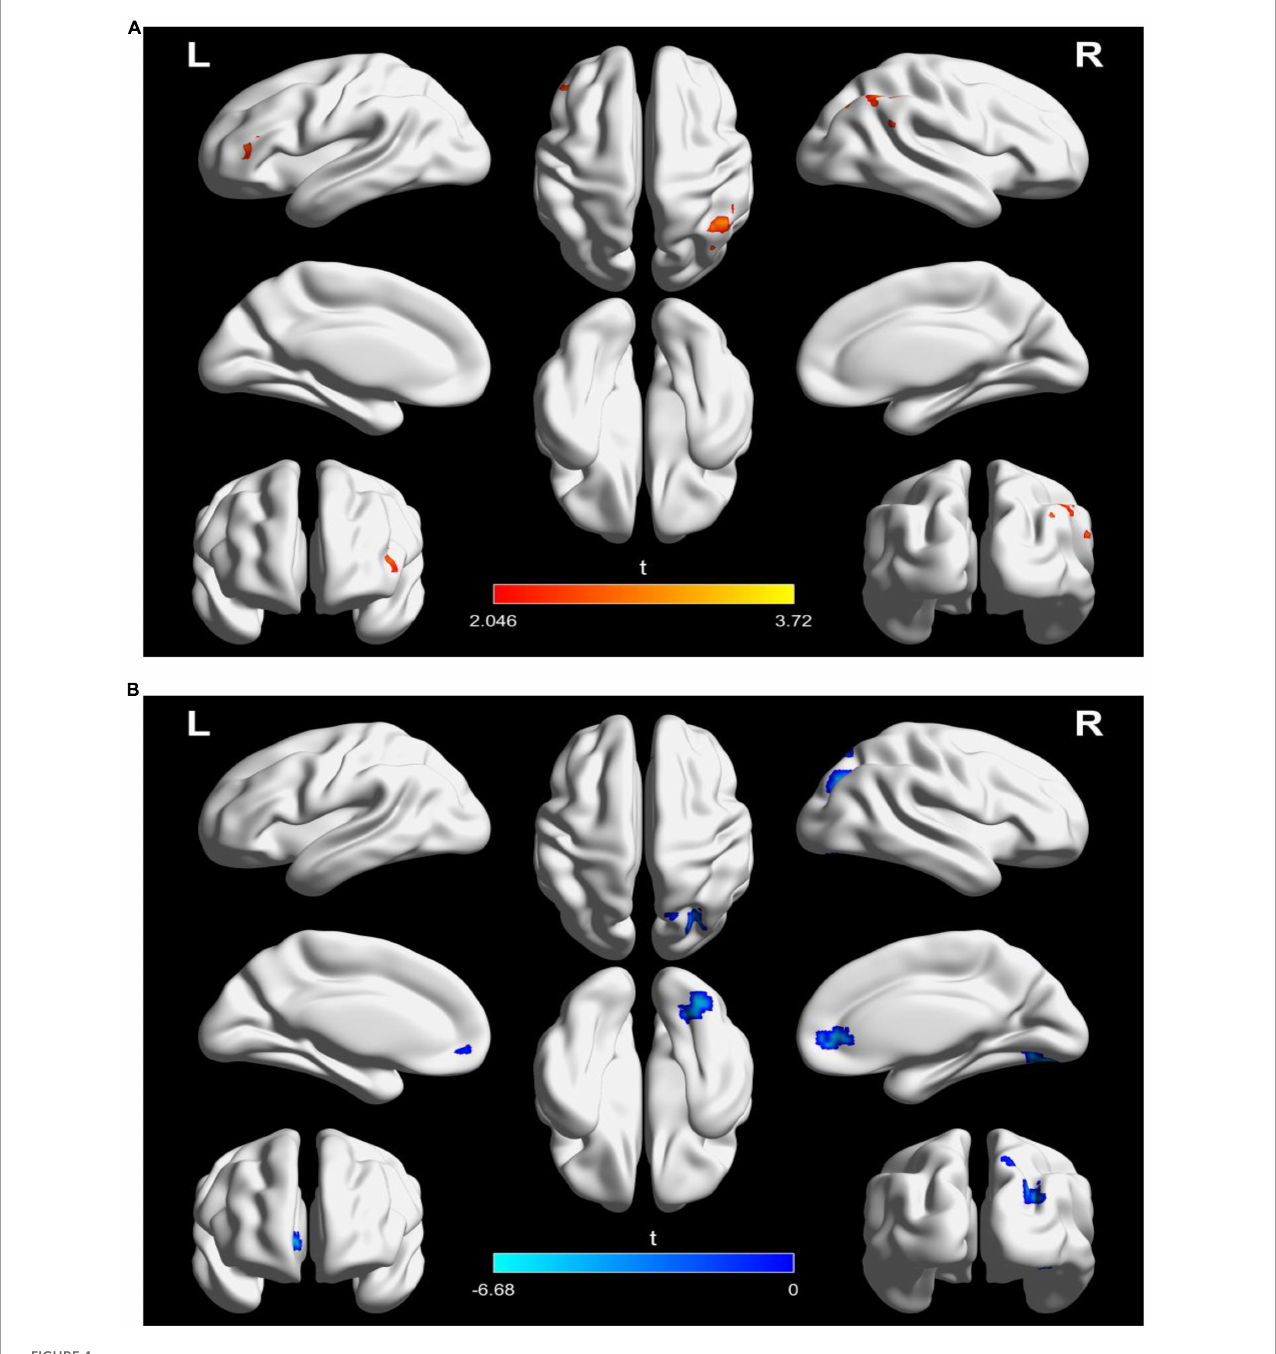
FIGURE4 Significantly changes in dynamic functional connectivity (DFC) of the left TPJ seed between before and after treatment in the two groups. (A) Significantly changes in DFC of the left TPJ seed in the active treatment group (posttreatment vs. pretreatment). (B) Significantly changes in DFC of the left TPJ seed in the placebo group (posttreatment vs. pretreatment). The warm color represents higher connectivity, and the cool color represents lower connectivity (GRF correction, p < 0.05, size > 30). TPJ, left temporoparietal junction; GRF, Gaussian random